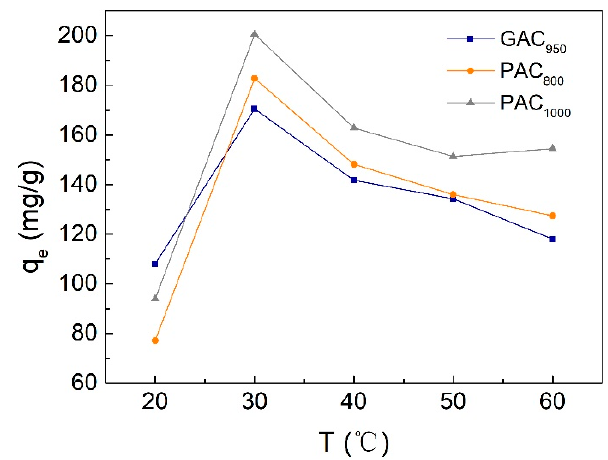
Figure 9. Effect of temperature value on phenol adsorption onto AC.